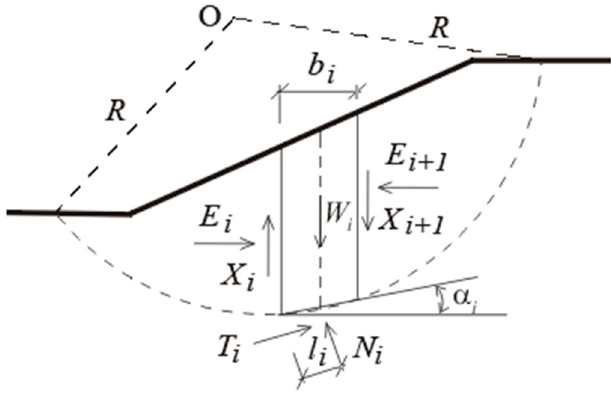
Figure 2. Definition of terms used in rotational failure analyses.